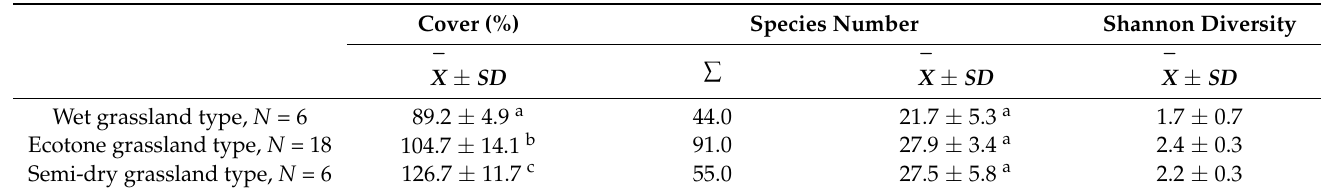
Table 1. Quantitative properties of the above-ground vegetation in the three grassland types under different water regimes. Cover (%) Species Number Shannon Diversity ¯ X ± SD Wet grassland type, N = 6 Ecotone grassland type, N = 18 Semi-dry grassland type, N =